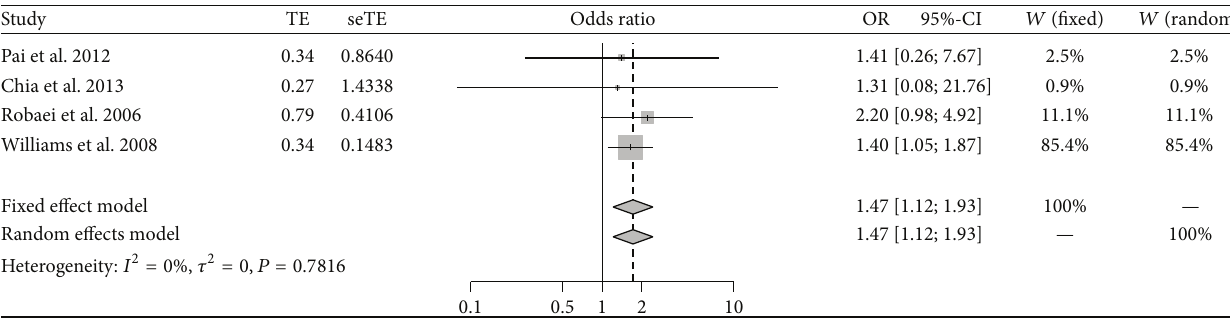
Figure 4: Meta-analysis for association of maternal smoking with childhood amblyopia.